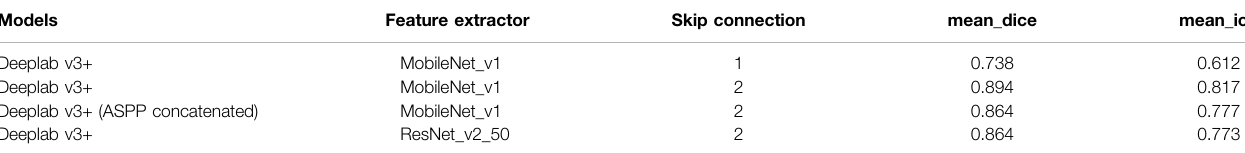
TABLE 2 | Performance of different